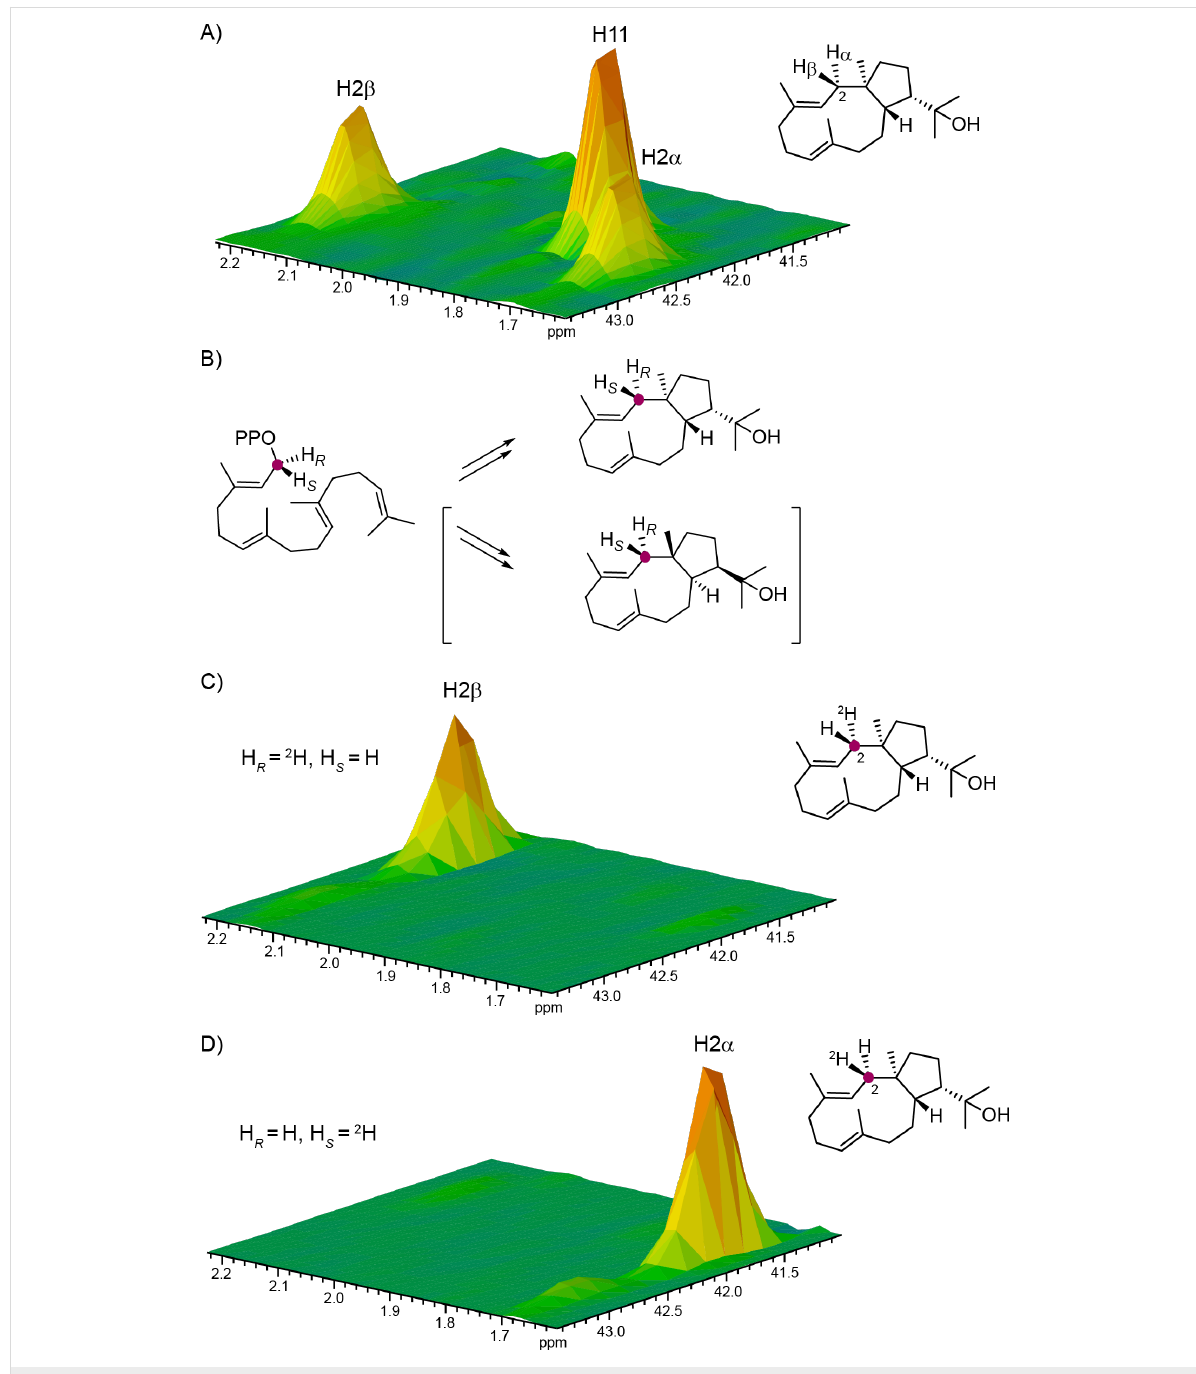
Figure 2: Determination of the absolute configuration of 3 . (A) Partial HSQC spectrum of unlabelled 3 showing the region for C2, (B) cyclisation of GGPP to the two possible enantiomers of 3 , (C) partial HSQC spectrum of the product obtained from ( R )-(1- 13 C,1- 2 H)GGPP, and (D) partial HSQC spectrum of the product obtained from ( S )-(1- 13 C,1- 2 H)GGPP. Purple dots indicate 13 C-labelled